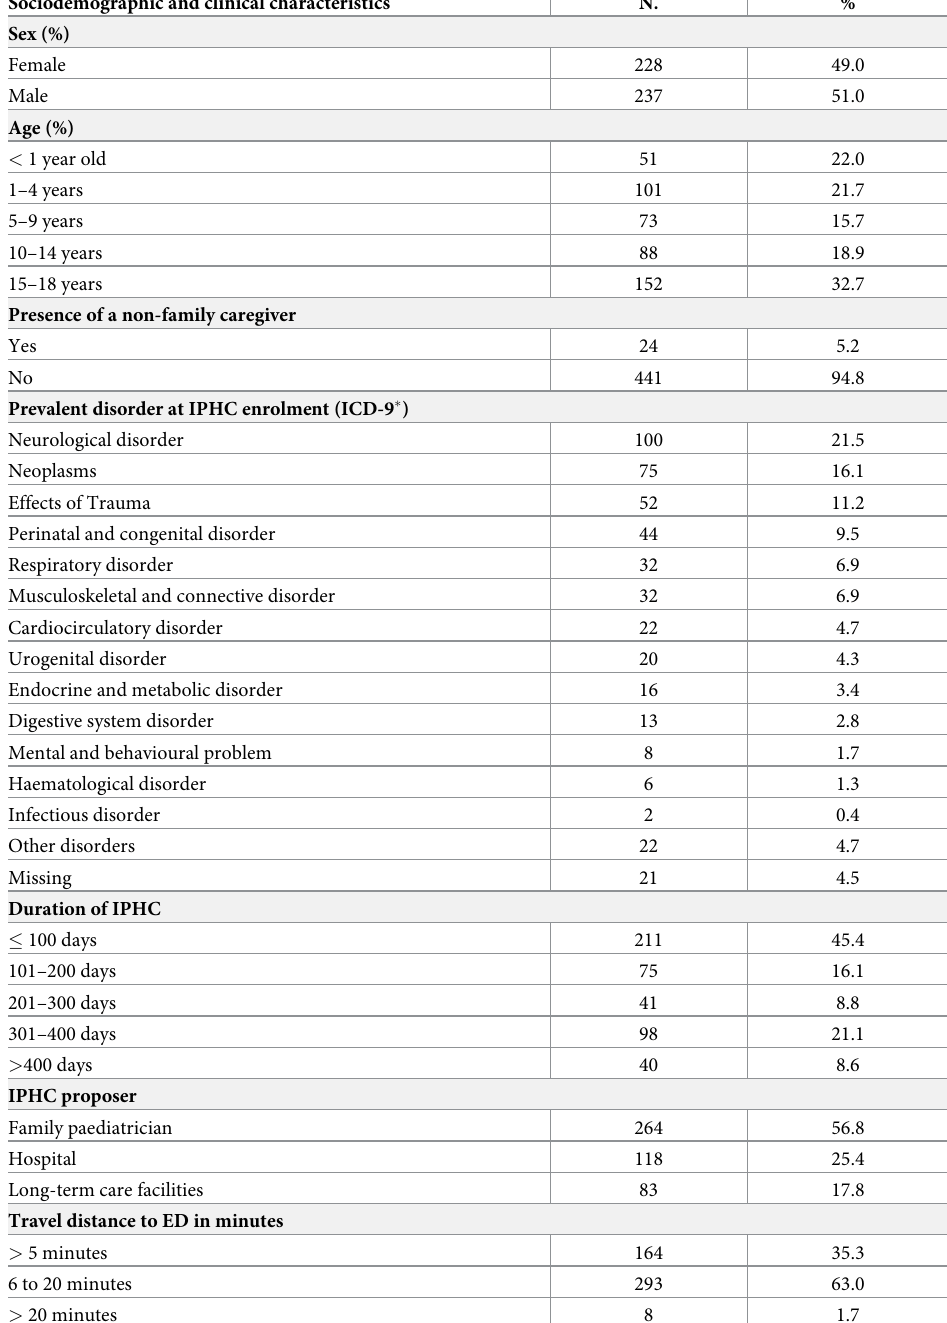
Table 1. Sociodemographic and clinical characteristics of the patients (n = 465) enrolled in the IPHC program between 2012 and 2017. Sociodemographic and clinical